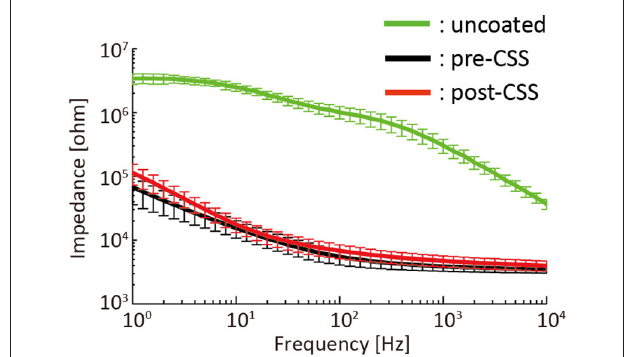
FIGURE 5 | Impedance spectra of 32 µ ECoG electrodes (mean ± standard deviation) that were measured before PEDOT-CNT coating (uncoated), after PEDOT-CNT coating but before any current injected (pre-CSS) and after the repeated CSS mappings